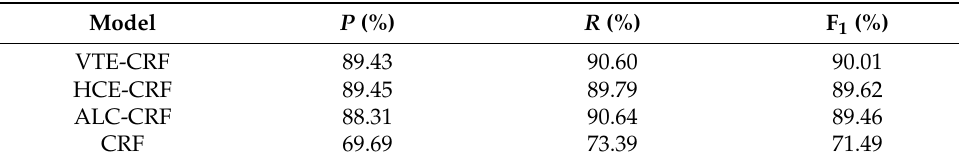
Table 5. The experimental results based on the CRF model.